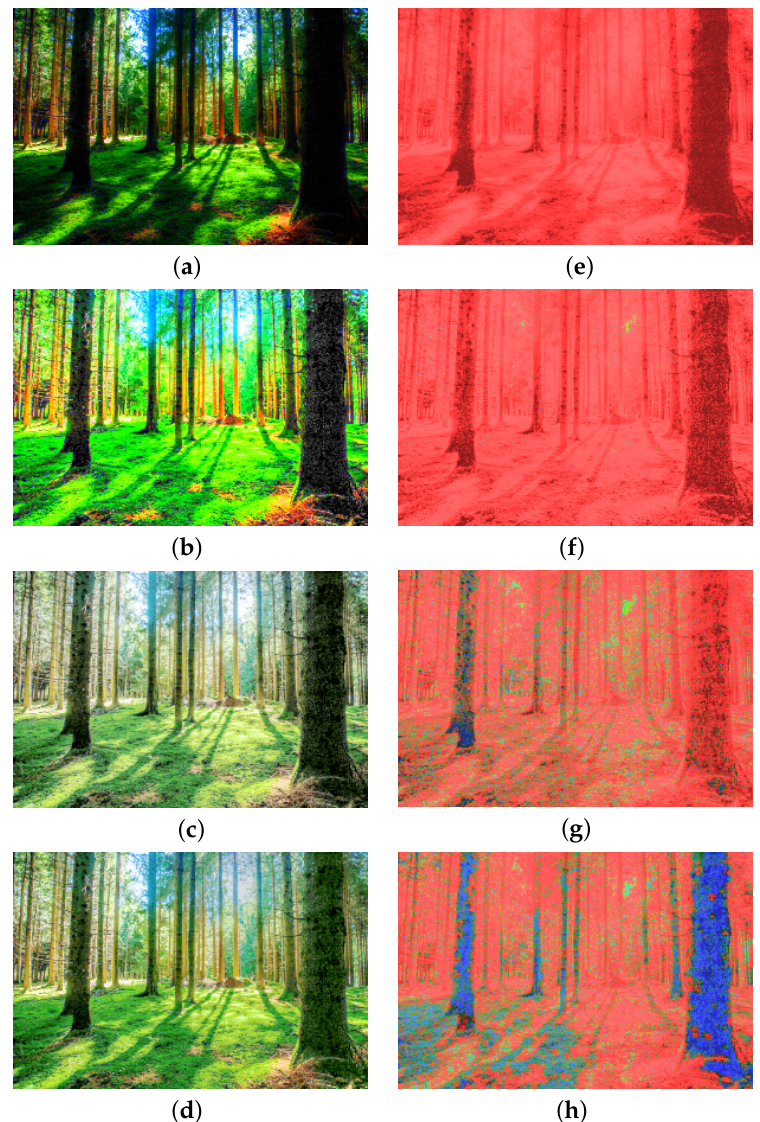
Figure 14. The comparison of our tone-mapped HDR result with those obtained from other methods. The HDR images are evaluated with HDR-VDP-2 [36] to compare and evaluate the VDP-Quality score. ( a ) Huo et al. [38]; ( b ) Masia et al. [39]; ( c ) Endo et al. [37]; ( d ) Ours; ( e ) VDP-Quality score: 55.67; ( f ) VDP-Quality score: 66.32; ( g ) VDP-Quality score: 70.21; ( h ) VDP-Quality score: